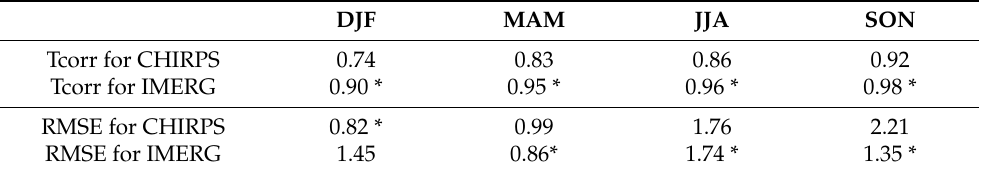
Table 3. Temporal correlation coefficient (Tcorr) and root mean square error (RMSE; unit: mm · d − 1 ) for comparison between time series of CWB and two SPPs shown in Figure 3. The one (CHIRPS or IMERG) with higher value of Tcorr or lower value of RMSE are marked by * for individual season. DJF MAM JJA SON Tcorr for CHIRPS 0.74 0.83 0.86